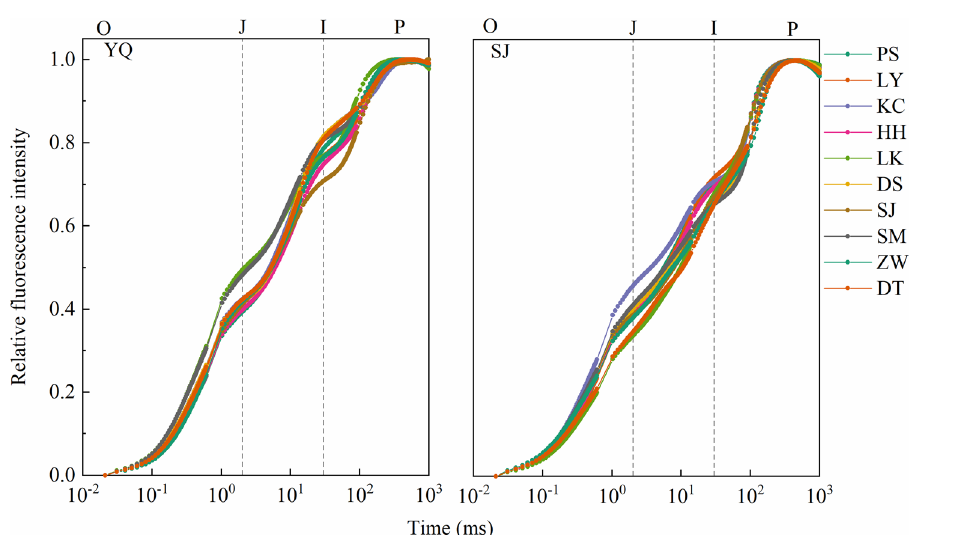
Figure 3. Normalized chlorophyll a fluorescence transient of Q. liaotungensis provenances. The O, J, I, and P steps are marked in the figure, where: O is for origin, J and I are for the intermediary fluorescence levels at 2 ms and 30 ms, and P is for the peak 20 . YQ represents the Yangqu test site, and SJ represents the Sanjiao test